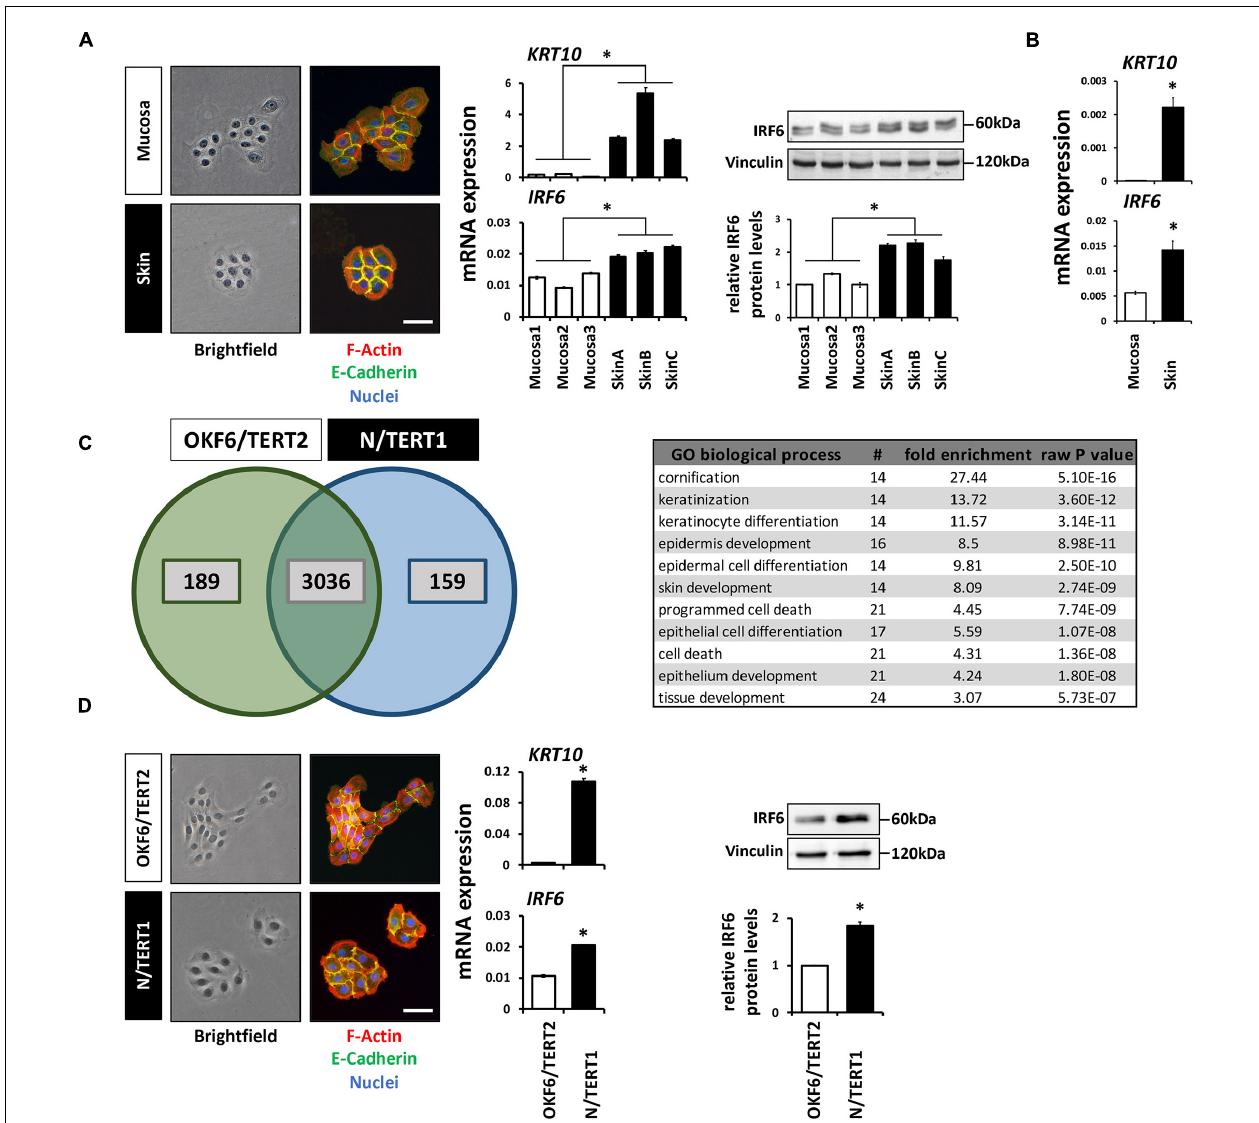
FIGURE 1 | (A) Comparison of the colony morphology, Keratin10 ( KRT10 ) and IRF6 expression in three individual primary oral mucosa-derived keratinocytes (Mucosa 1-3) compared to three foreskin-derived keratinocytes (Skin A-C). Note that the skin-derived cells form tightly packed colonies, express high levels of KRT10 , and express more IRF6 than mucosa-derived cells. ∗ p < 0.05 (IRF6 and KRT10 levels in Skin vs. Mucosa). Scale bar: 100 µ m. kDa: kilo Dalton. (B) KRT10 and IRF6 mRNA levels of mucosal- and skin-derived keratinocytes from the same donor show higher expression of both genes in the skin. ∗ p < 0.05 ( KRT10 and IRF6 levels in Skin vs. Mucosa). (C) Venn diagram of the proteomic analysis comparing OKF6/TERT2 (oral mucosa) and N/TERT1 (foreskin) keratinocytes reveals a high number of proteins present in both cell lines, 189 and 159 proteins are unique to OKF6/TERT2 and N/TERT1, respectively. From the 3,036 shared proteins, 91 proteins are differentially expressed ( > 2 fold) and mostly associated with the biological processes of epidermal differentiation, keratinization, and cornification (table right). (D) Similar to the observations in primary keratinocytes, N/TERT1 keratinocytes form more cohesive and regularly shaped colonies and express higher levels of KRT10 and IRF6 than the oral mucosa-derived OKF6/TERT2. Scale bar: 100 µ m. ∗ p < 0.05 ( KRT10 levels in Skin vs. Mucosa); ∗ p < 0.05 (IRF6 levels in Skin vs. Mucosa). Full-length immunoblots are shown in Supplementary Figure 9